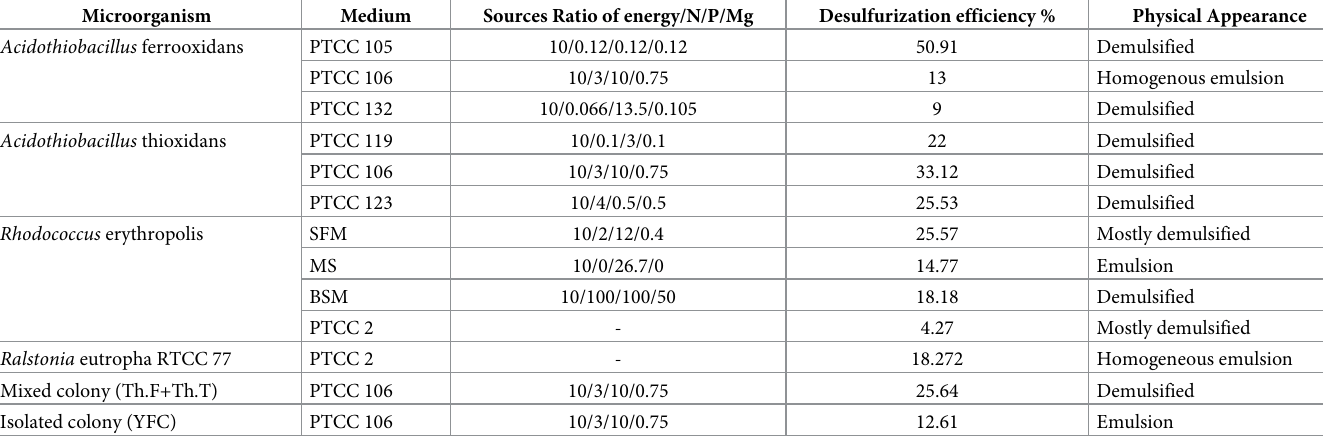
Table 1. The efficiencies of both microorganisms and environmental mediums on the BDS of whole sour heavy crude oil.